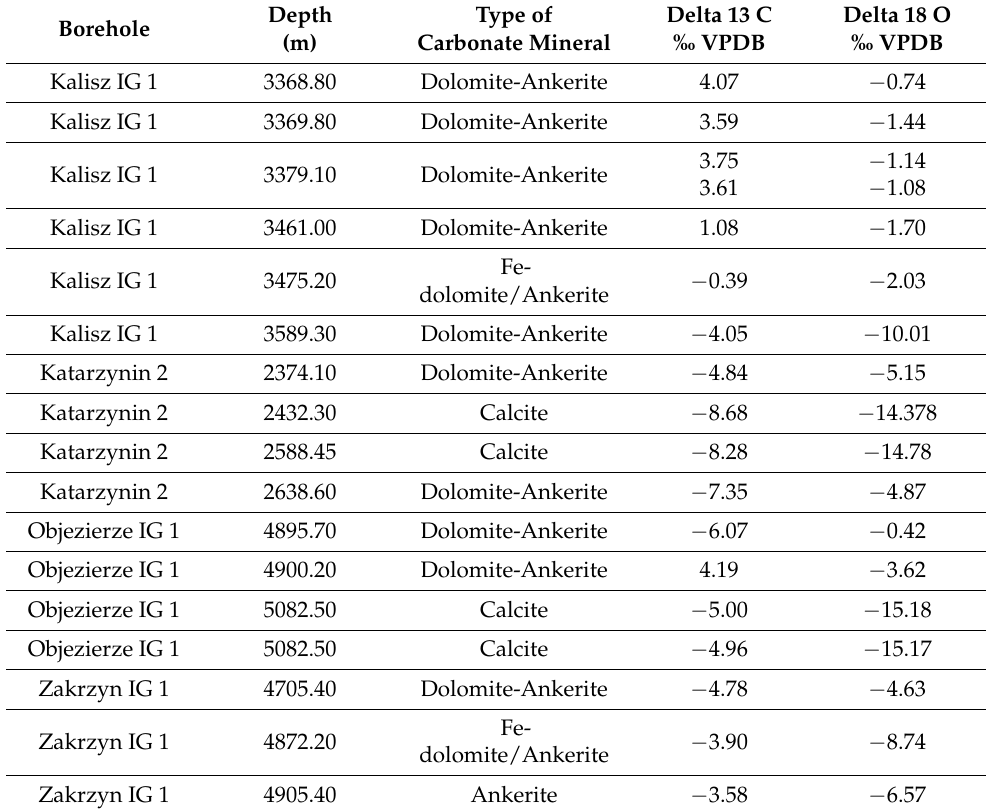
Table 3. Carbon and oxygen isotopic